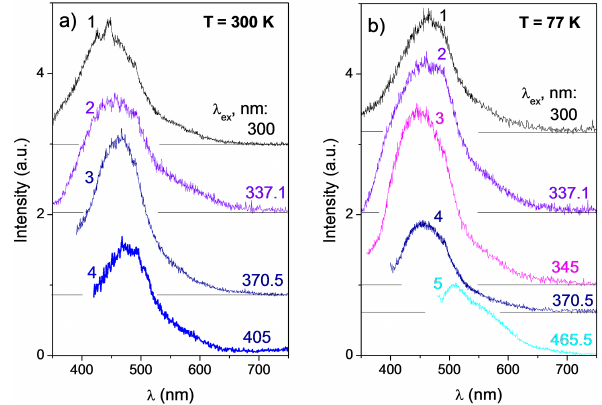
Figure 3. The PL spectra of the CDW samples at 300 (a) and 77K (b) ; λ ex = 300 ( a , 1; b , 1), 337.1 ( a , 2; b , 2), 345 ( b , 3), 370.5 ( a , 3; b , 4), 405 ( a , 4), and 465.5nm ( b ,